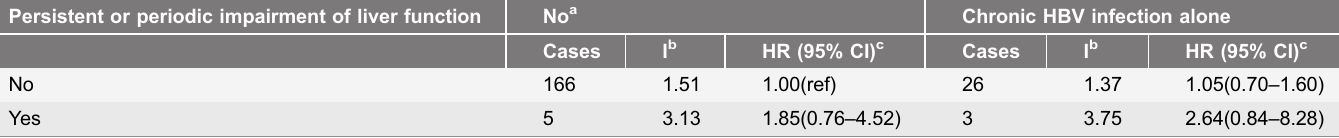
Table 5. Association between the development of rheumatoid arthritis (RA) and chronic HBV infection concurrent with persistent or periodic impairment of liver function. Persistent or periodic impairment of liver